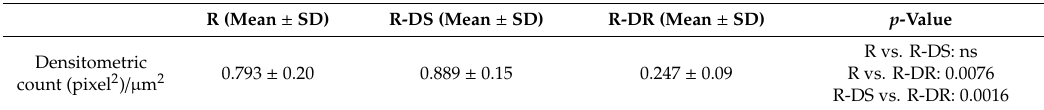
Table 5. COL II Immunostaining—Articular